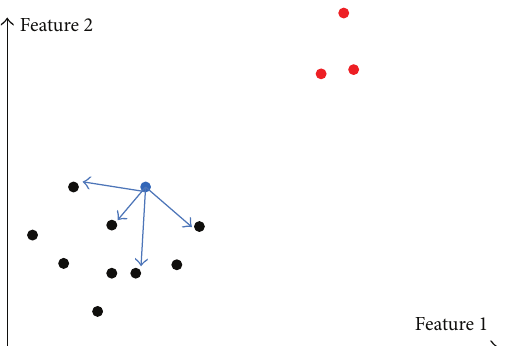
Figure 2: The effect of 𝐾 value on abnormal node’s 𝐾 -distance function (𝐾 = 2 < 𝑚2) .